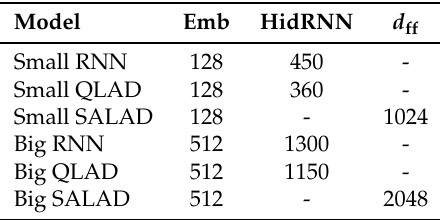
Table 1. Different layer sizes of the different models. Emb, linear embedding layer, and hidden size H for SALAD models in all layers but FFN ones; HidRNN, Hidden LSTM or QRNN layer size; d ff , dimension of the feed-forward hidden layer inside the FFN. Model Emb HidRNN d ff Small